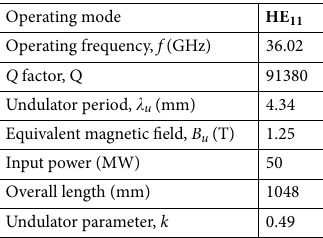
Table 2. Key parameters of the 36 GHz cavity-type microwave